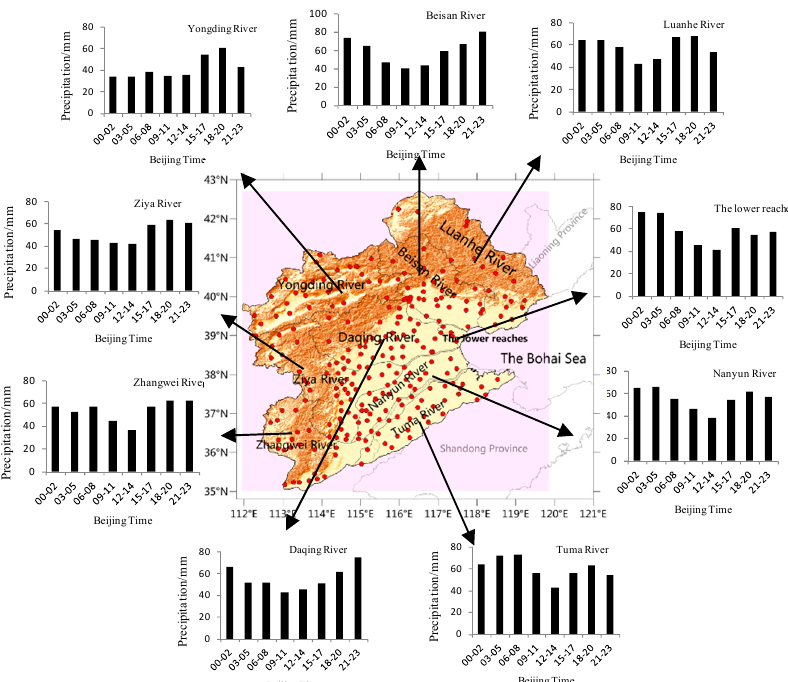
Figure 5. The diurnal variations of hourly mean precipitation for the tributaries in the Haihe River basin.